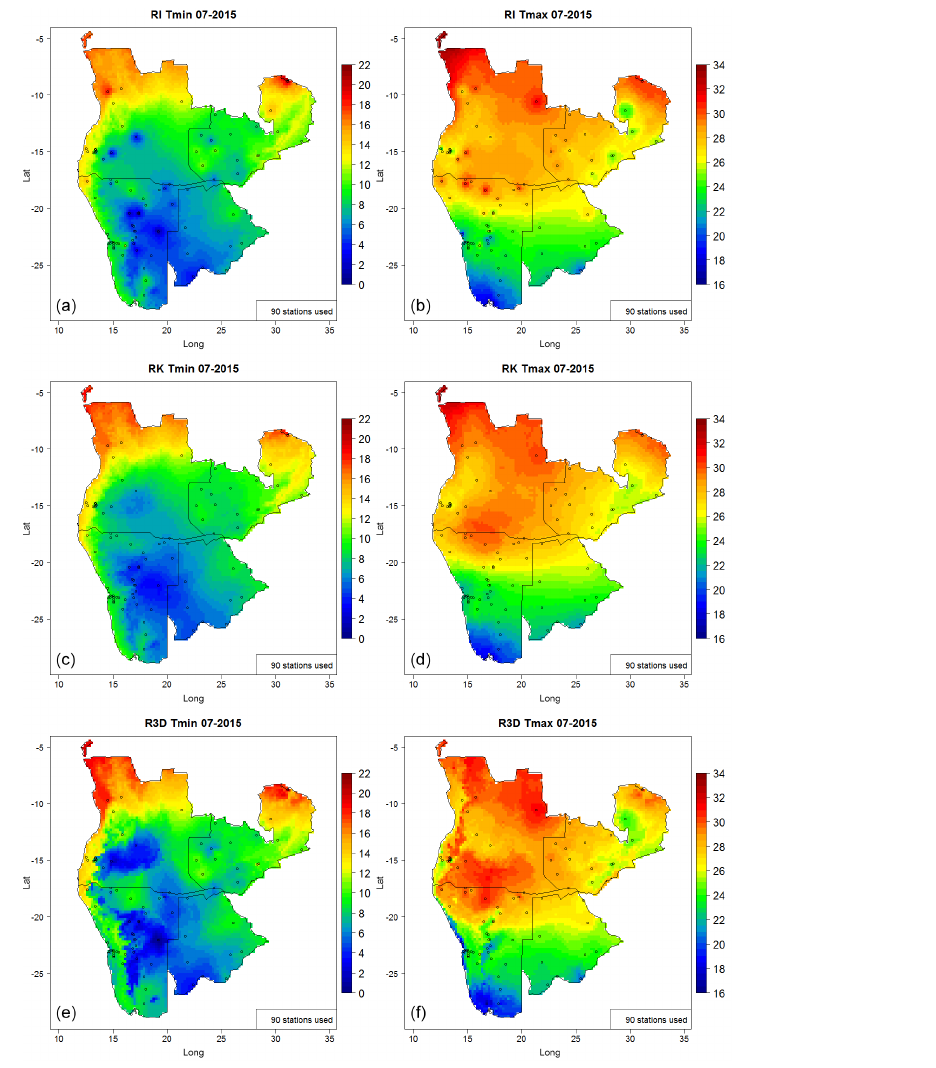
Figure 6. Temperature map of July 2015 on basis of RI (a, b) , RK (c, d) and R3D (e, f)